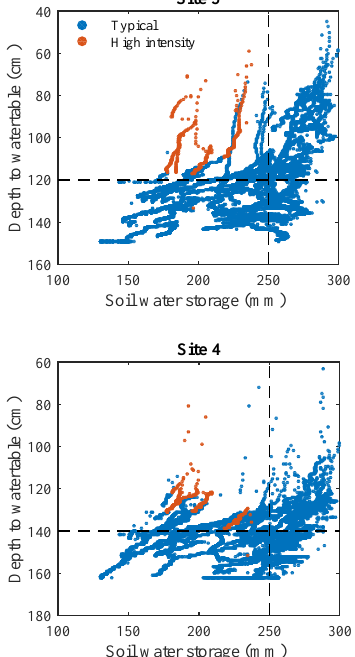
Figure 7. Soil water storage vs. water table level at sites 4 and 5. The red colour distinguishes events with high hourly rainfall inten- sity, defined as I peak >15mm, consistent with Fig. 5. The dashed black lines correspond to values of water level and soil water stor- age discussed in the text. Soil water storage is measured for the top 60cm at the Automatic Weather